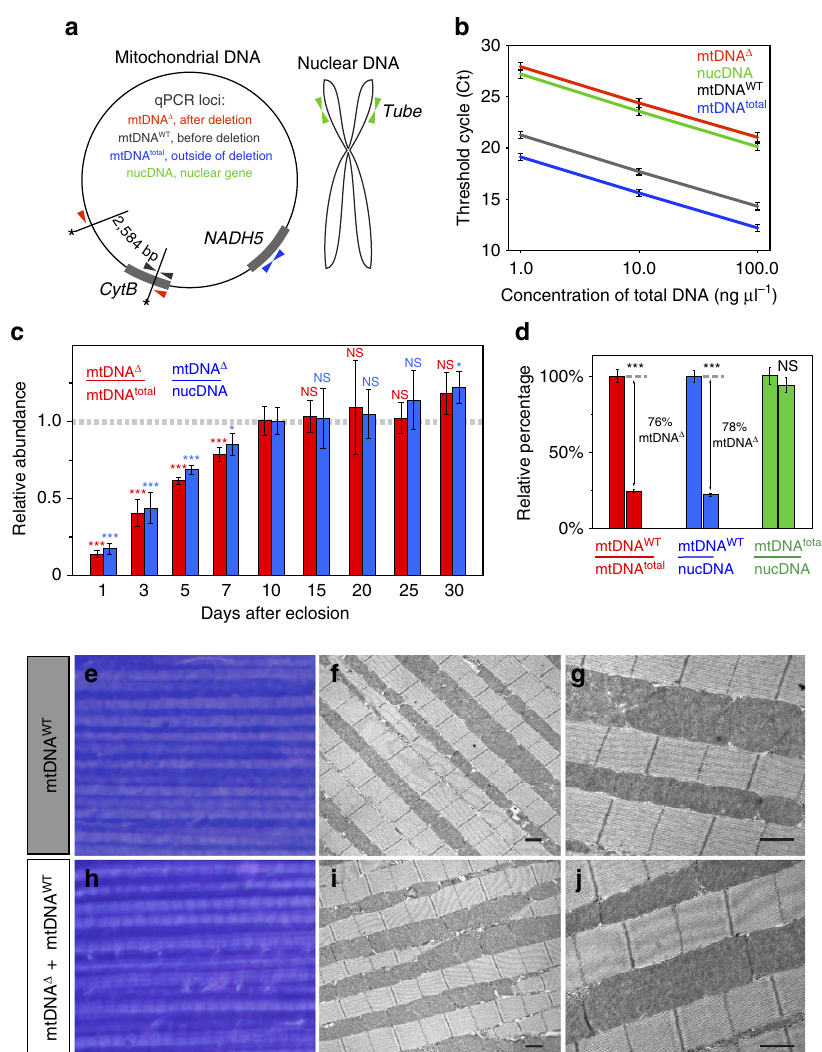
Figure 2 | qPCR quantification of mtDNA species and effects of heteroplasmy on muscle structure. ( a ) Positions and orientations of qPCR primers are indicated by arrows. ( b ) Four standard curves connecting three average Ct values ( ± 1 s.d.) for each primer set. ( c ) The amount of mtDNA D in the IFMs of mitoAflIII flies increases through the first 10 days after eclosion and stabilizes afterwards. Relative amounts of mtDNA D were estimated using qPCR normalized to the levels observed in 10-day-old flies, which were assigned the value of 1. Minimum four biological replicates were quantified for each time point. Statistical significance is calculated relative to the values in 10-day-old flies. ( d ) Quantification of mtDNA forms in flight muscle from 10-day-old P{ pIFM-Gal4 }attP1 (wild type, left bar of each pair) and mtDNA D -bearing P{ pIFM-mitoAflIII, pIFM-mitoT4lig, pIFM-Gal4 }attP1 ( mitoAflIII, right bar of each pair) flies. mtDNA WT depletion among all mtDNA molecules (mtDNA total ) corresponds to emergence of mtDNA D molecules: that is, mtDNA total (cid:3) mtDNA WT ¼ mtDNA D . Bars depict mean ± 1 s.d. ( e , h ) Toluidine blue staining, and ( f , g , i , j ) transmission electron micrographs of indirect flight muscles of 10-day-old flies. Wild-type ( e – g ) and mitoAflIII ( h – j ) flies have similar muscular ultrastructure. Scale bars, 1.0 m m. Statistical significance was calculated using Student’s t- test with unequal variance.